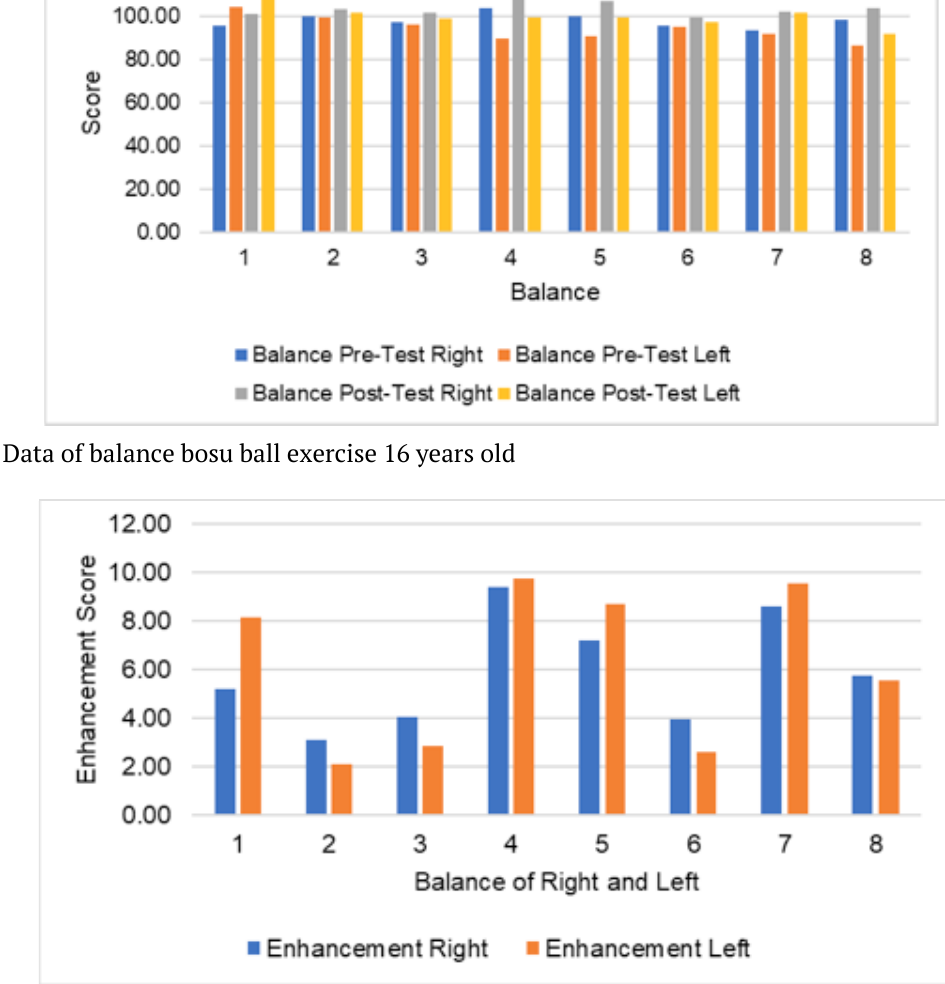
Figure 6. Enhancement of balance bosu ball exercise 16 years